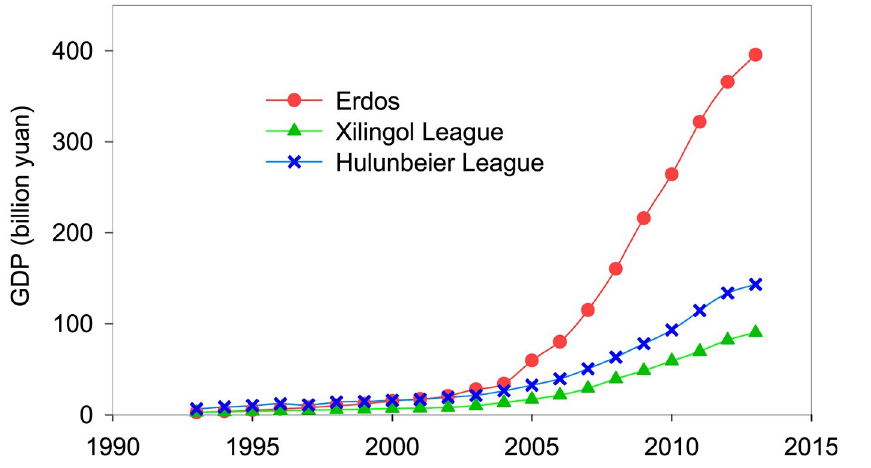
Fig 6. GDP of the typical coal mining areas in Inner Mongolia during the study period